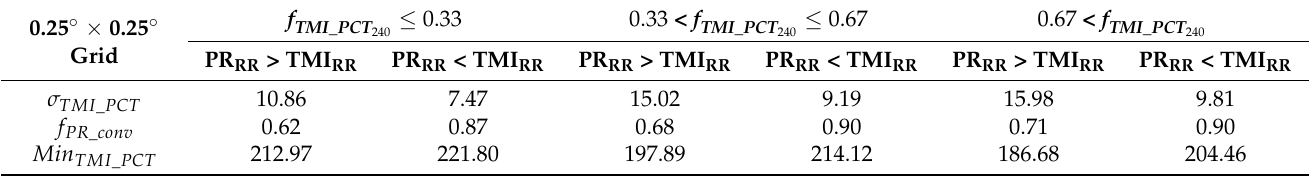
Table 2. Difference in the statistical characteristics of gridded TMI 85 GHz PCT standard deviation, PR convective fraction, and minimum TMI 85 GHz PCT for deep precipitation system based on fraction of number of TMI 85 GHz PCT below 273 K threshold (Source: data